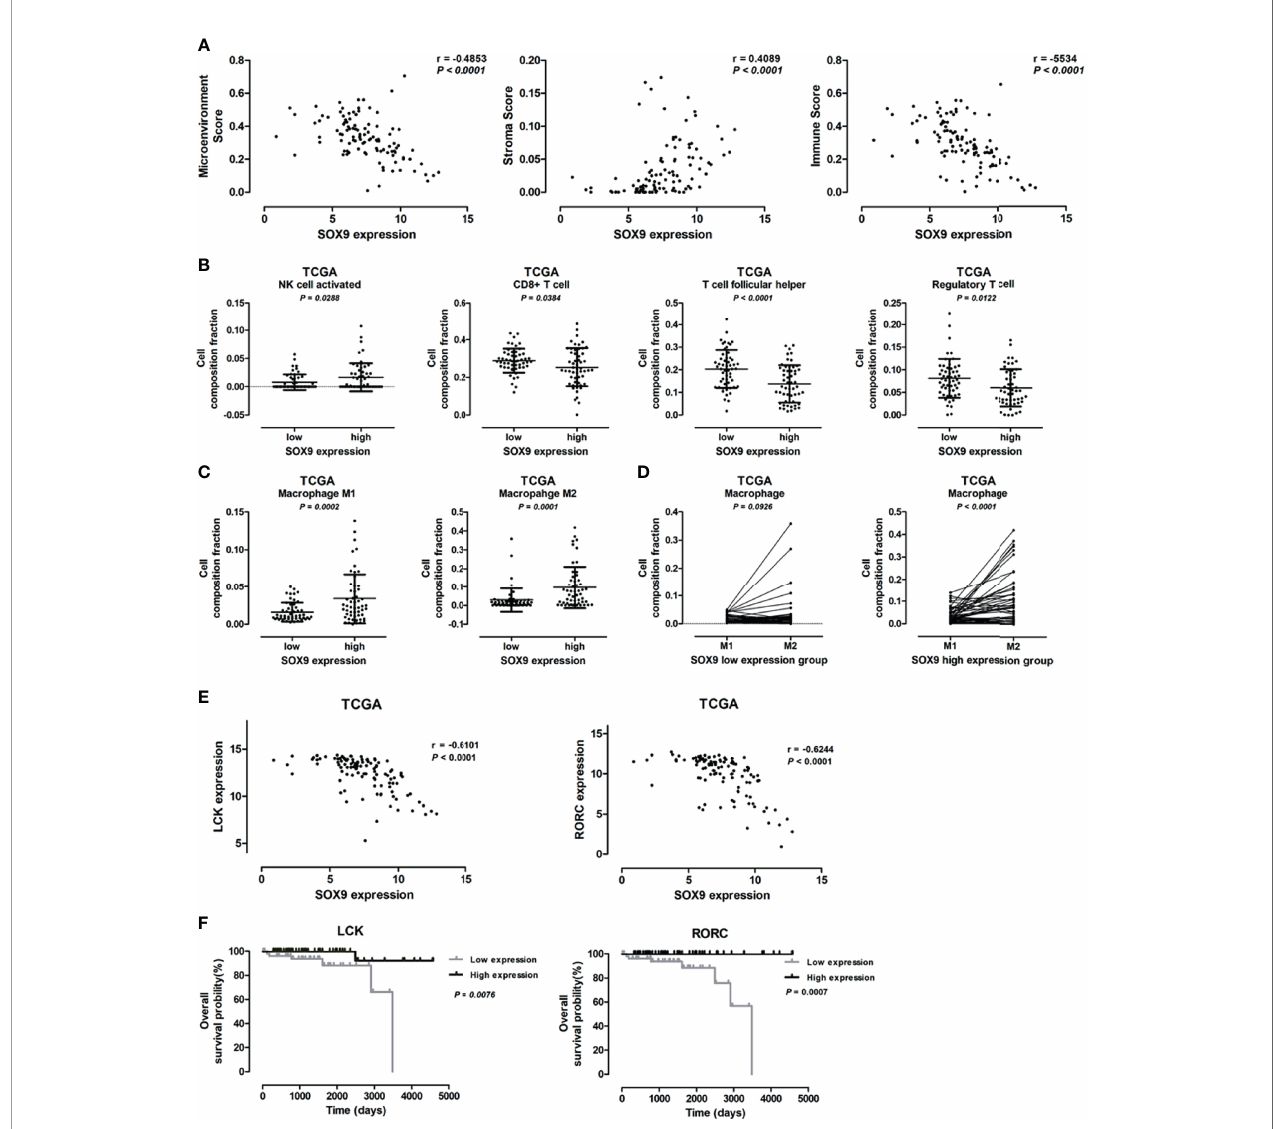
FIGURE 5 | Correlation between SOX9 expression and immune cells in fi ltration level. (A) Scatter plots illustrating the pearson correlation analysis for the associations of SOX9 expression with tumor microenvironment score, stroma score, and immune scores in thymomas, respectively. (B) Dot plots representing the in fi ltration of immune cells, including activated natural killer cell, CD8+ T cell, follicular T cell, and regulatory T cell, between patients with high and low SOX9 expressions. (C) Dot plots representing M1 and M2 cells between patients with high and low SOX9 expressions. (D) Dot plots representing the in fi ltration of M1 and M2 cells in patients with high or low SOX9 expression. (E) Scatter plots illustrating the pearson correlation analysis for the associations of SOX9 expression with LCK and RORC expression in thymomas, respectively. (F) Kaplan – Meier survival curves showing that thymoma patients from TCGA dataset with low LCK or RORC RNA expression had shorter overall survival time ( P < 0.05), as determined by the log-rank test. Thymoma patients (n = 108) were categorized into high and low LCK or RORC expression groups with the median value of LCK or RORC mRNA expression level as